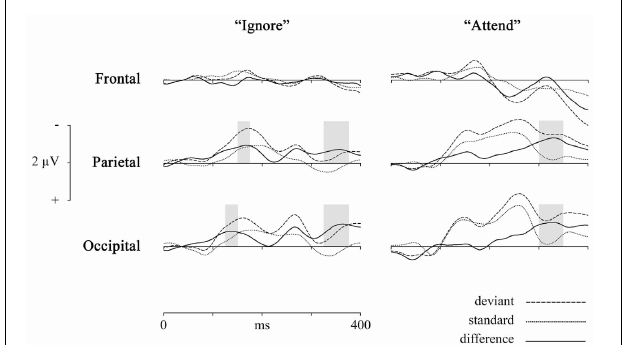
FIGURE 2 | Group average ( n = 40) ERPs elicited by deviant (dashed line) and standard (dotted line) events and difference waveforms (deviant—standard, solid line) in 2 conditions (“Ignore,” “Attend”) and 3 scalp locations (comprised of pooled electrodes). Highest mean amplitudes for difference waveforms are marked with colored